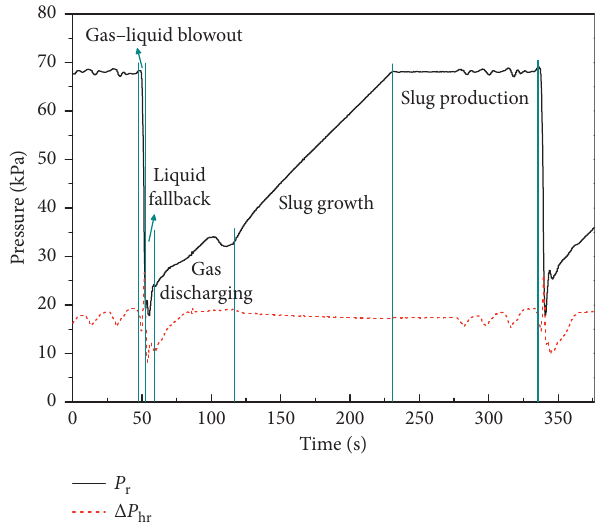
Figure 3: Pressures of P r and Δ P hr for severe slugging of type